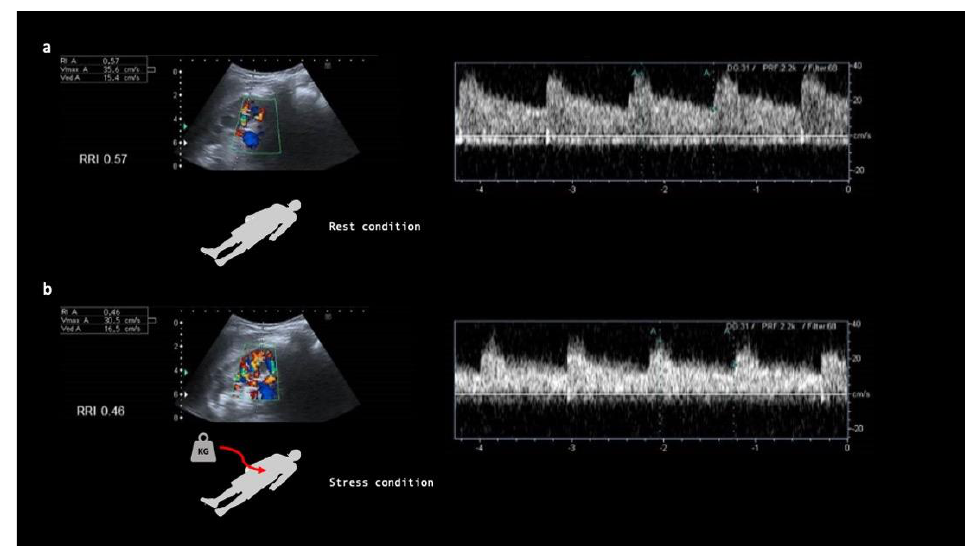
Figure 1. Renal Stress Test (RST) is based on the measurement of the percentage change in the intraparenchymal renal resistive index (IRRIV) between the basal status in rest condition ( a ) and after an external stress to study the RFR ( b ). In resting conditions ( a ), the RRIs are measured by studying the average value which is then used to calculate the percentage and absolute variation with respect to the values found after the stress ( b ) applied to the kidney through the application of the weight on the anterior abdominal wall. The figure shows the sampling points of the Doppler signal in the kidney and the relative Doppler spectra that are used for the calculation of the RRI.